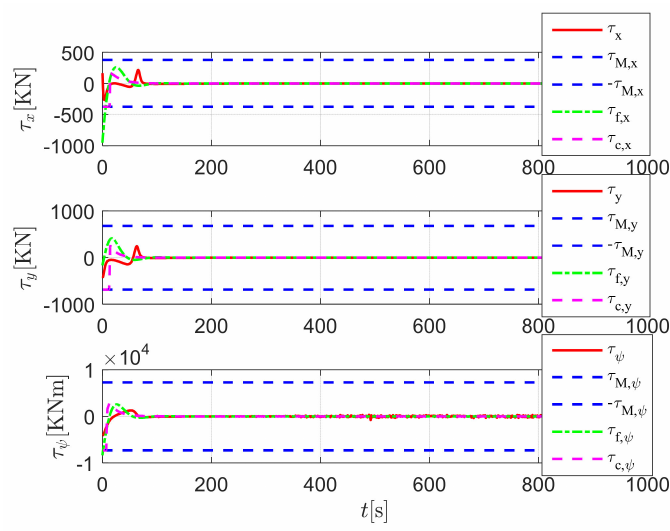
Figure 6. The time response curves of ship’s velocities in Case 1.